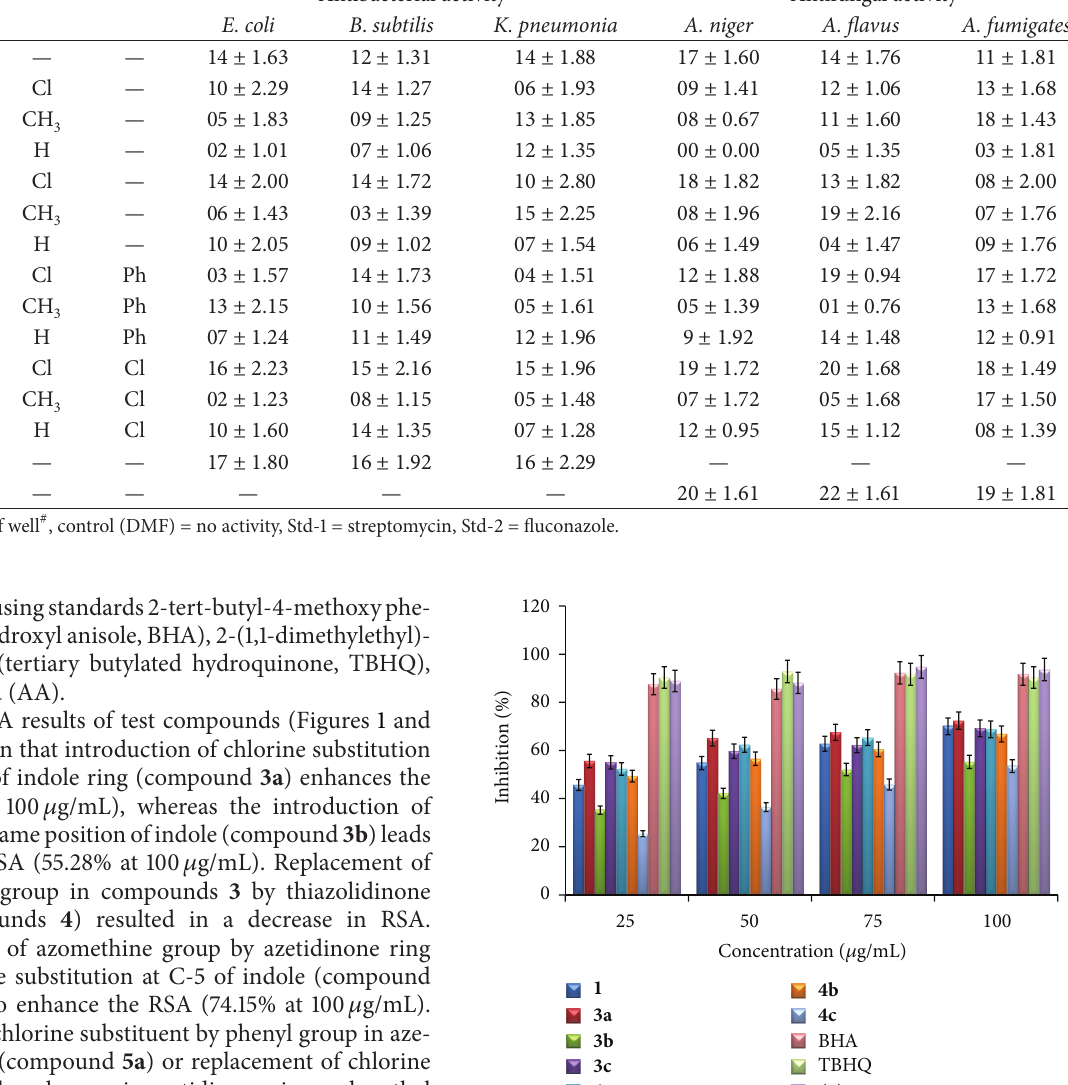
Table 1: Antimicrobial activities of the compounds ( 1 and 3–5 ). Compound no.